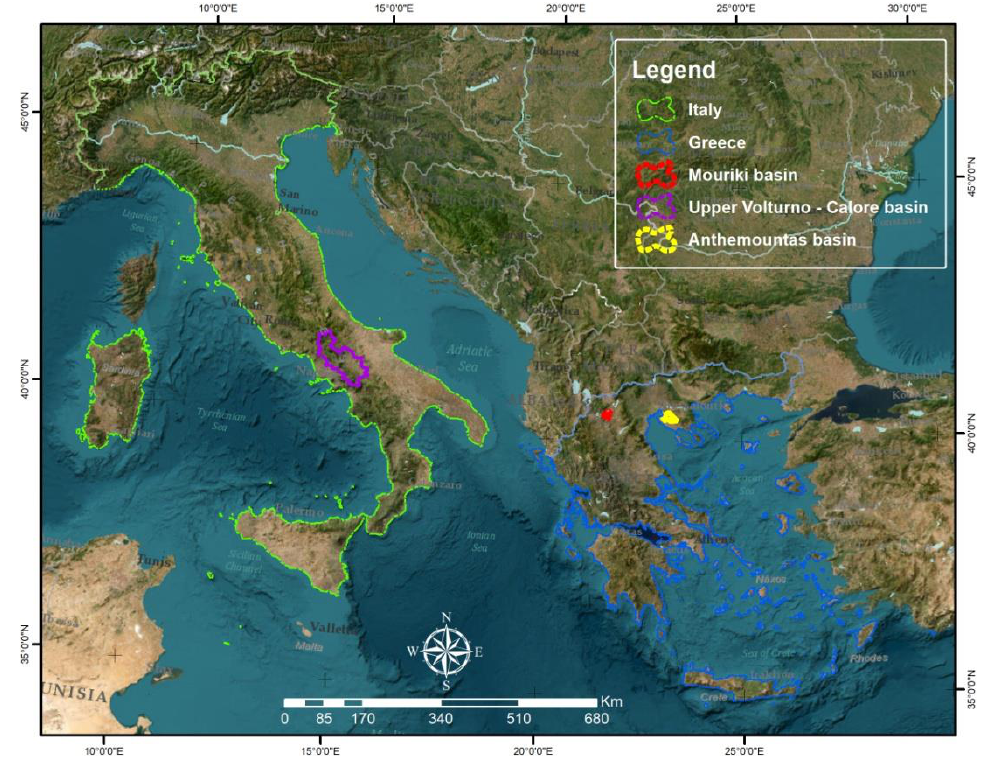
Figure 1. Geographical distribution of the station used in this study.